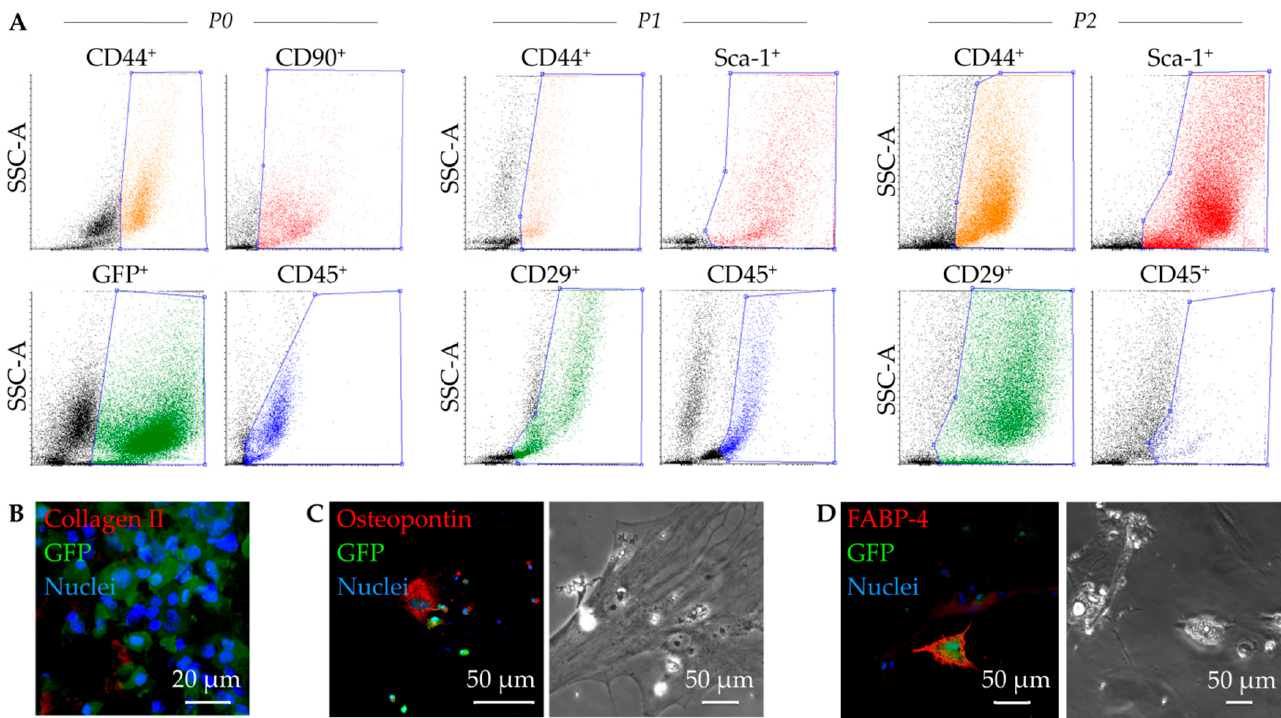
Figure 1. Functional characterization of murine mesenchymal stem cells (MSC). Representative dot plots of the flow cytometric analysis show GFP + expressing cells (green, B6 eGFP mouse strain), as well as phenotypic alterations in expression of the MSC relevant surface markers over passages: CD44, CD90, CD45 at passage 0 (P0), as well as CD44, Sca-1, CD29, and CD45 at P1, and P2 ( A ). MSC demonstrate a multipotent differentiation potency proved by immunofluorescence staining and positive expression of collagen II after chondrocytic differentiation ( B ), osteopontin after osteocytic differentiation ( C ), and fatty acid binding protein 4 (FABP 4) after adipocytic differentiation ( D ). Phase contrast images illustrate morphological characteristics following respective differentiations: cytoskeletal structures for osteocytes ( C ) and lipid drops with visible vacuoles for adipocytes ( D ).